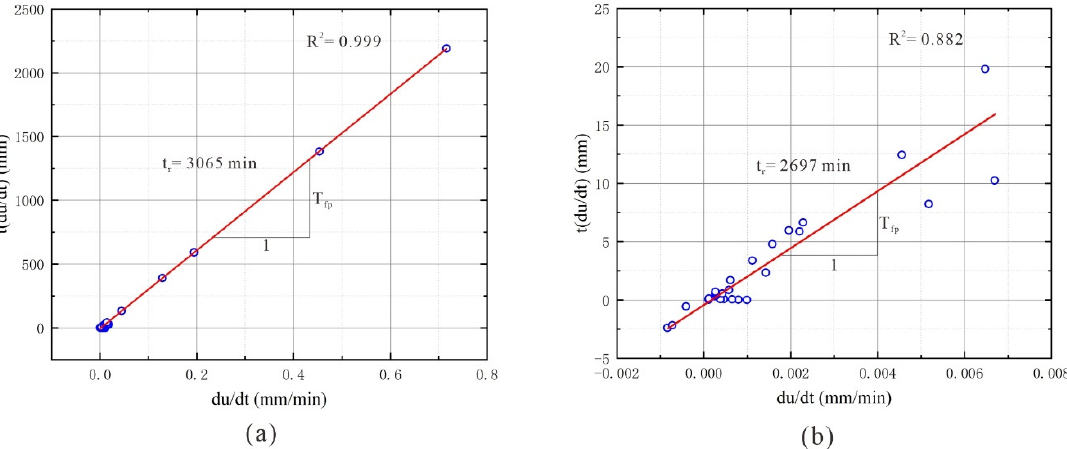
Figure 11. Typical plots used to predict slope failure using the SLO method: ( a ) slope front; and ( b ) slope side.